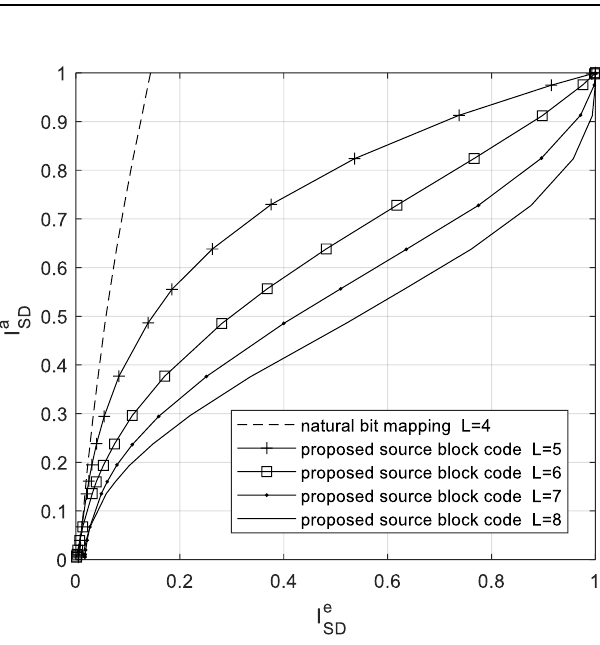
Figure 3. The EXIT curves of different source codes.